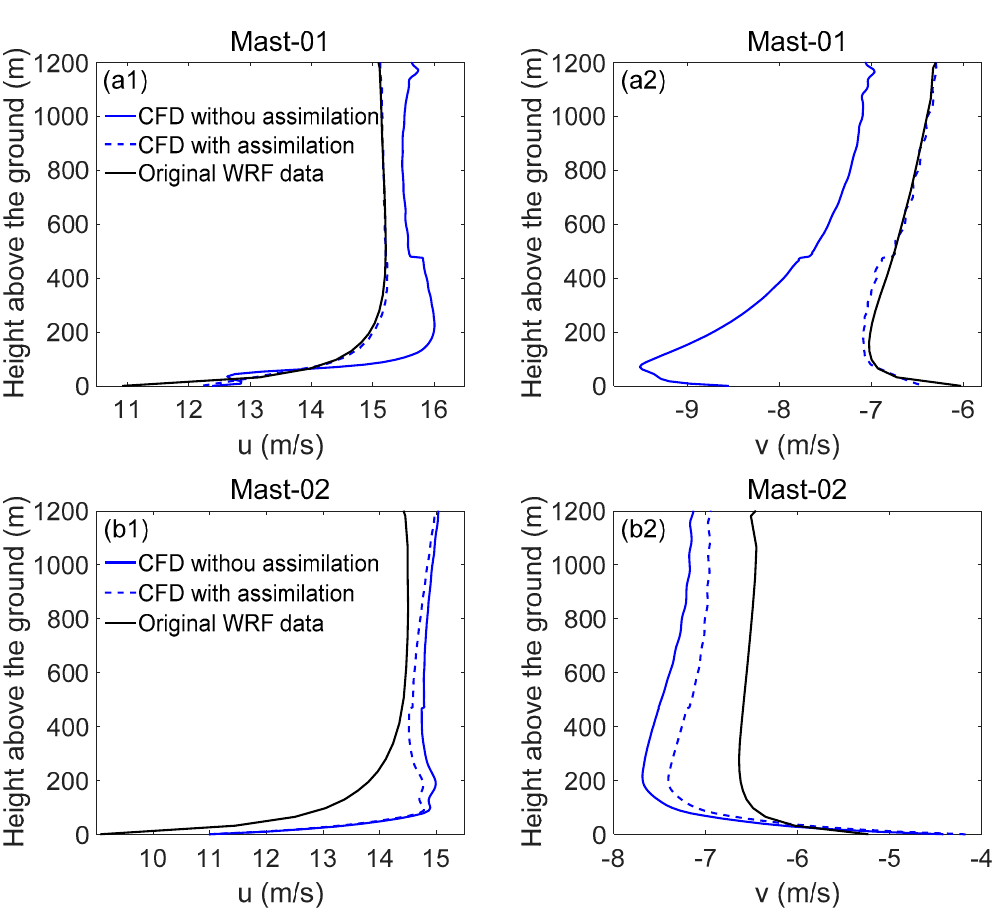
Figure 13. The u , v velocity profiles of the CFD simulation without assimilation, with assimilation, and the original WRF data at two sites: ( a1 , a2 ) Mast-01; ( b1 , b2 ) Mast-02.